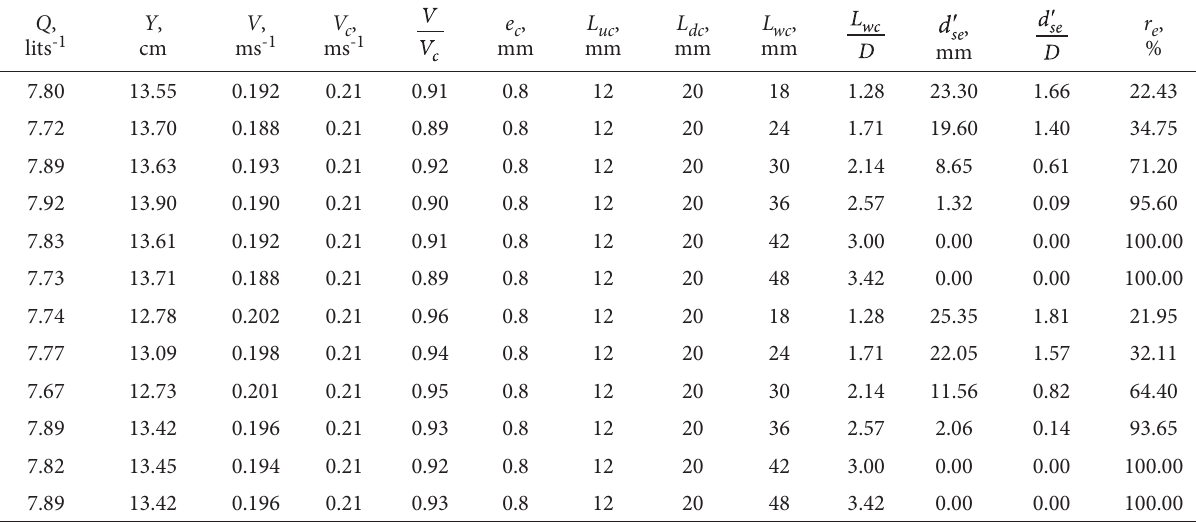
Table 5. Characteristics of bridge pier model scour experiments under two-sided collar with varying width condition Q , lits